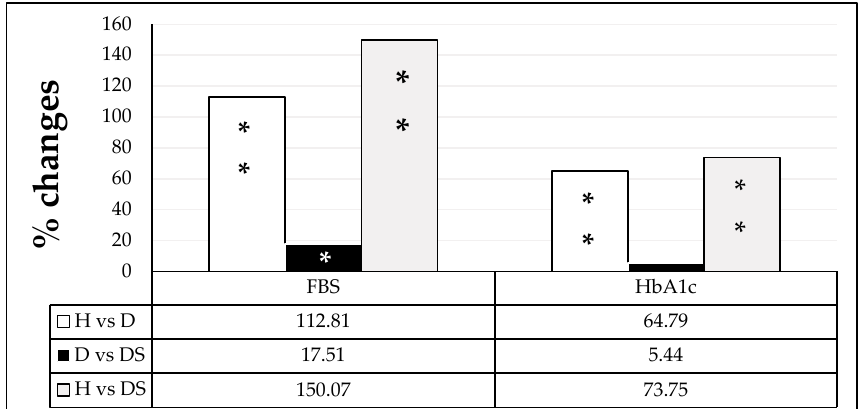
Figure 2. Percentage of change in fasting blood glucose (FSG) and hemoglobin A1C (HbA1C) among healthy individuals (H), diabetic patients (D), and diabetic patients sweetener consumers (DS). The comparison was performed using one-way ANOVA. Values presenting p > 0.05 were considered non-significant (NS). Significant values are represented by * p < 0.05 and ** p < 0.001.